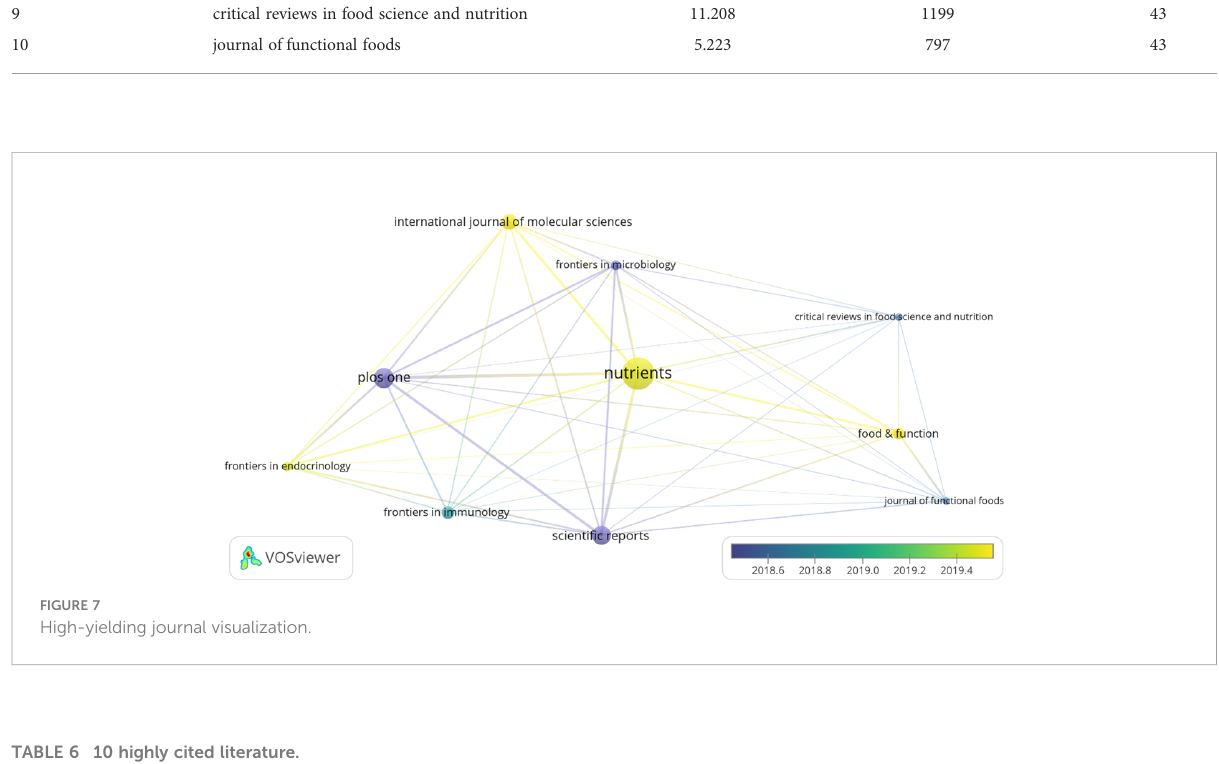
TABLE 6 10 highly cited